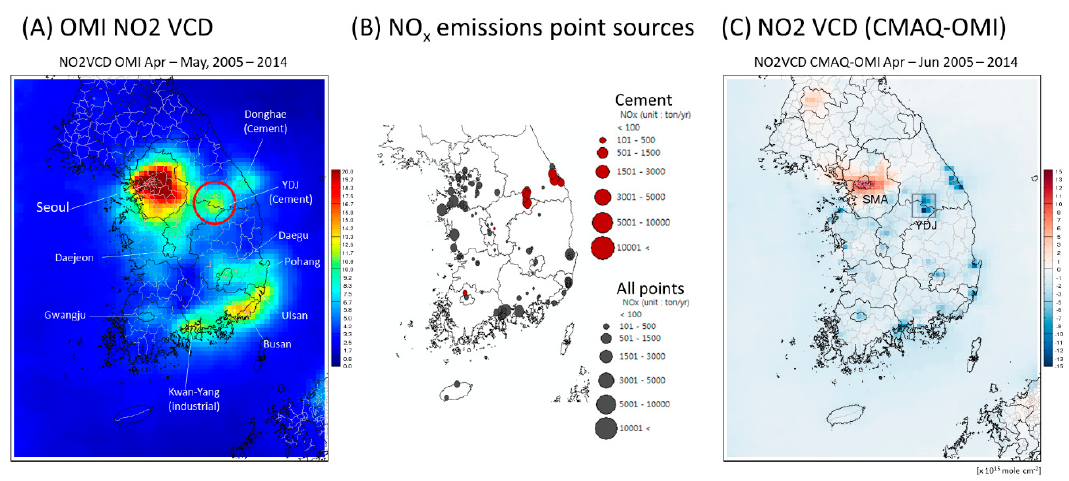
Figure 1. Spatial distributions of ( A ) Ozone Monitoring Instrument (OMI) NO 2 volume column density (VCD), ( B ) NO x emissions from the Clean Air Policy Support System (CAPSS) 2010 emission inventory, and ( C ) difference in NO 2 VCD between Community Multiscale Air Quality Model (CMAQ) (with averaging kernel) and OMI (downscaling applied). See the body of the paper for details about the averaging kernel and downscaling techniques. The gray box indicates the YDJ region.